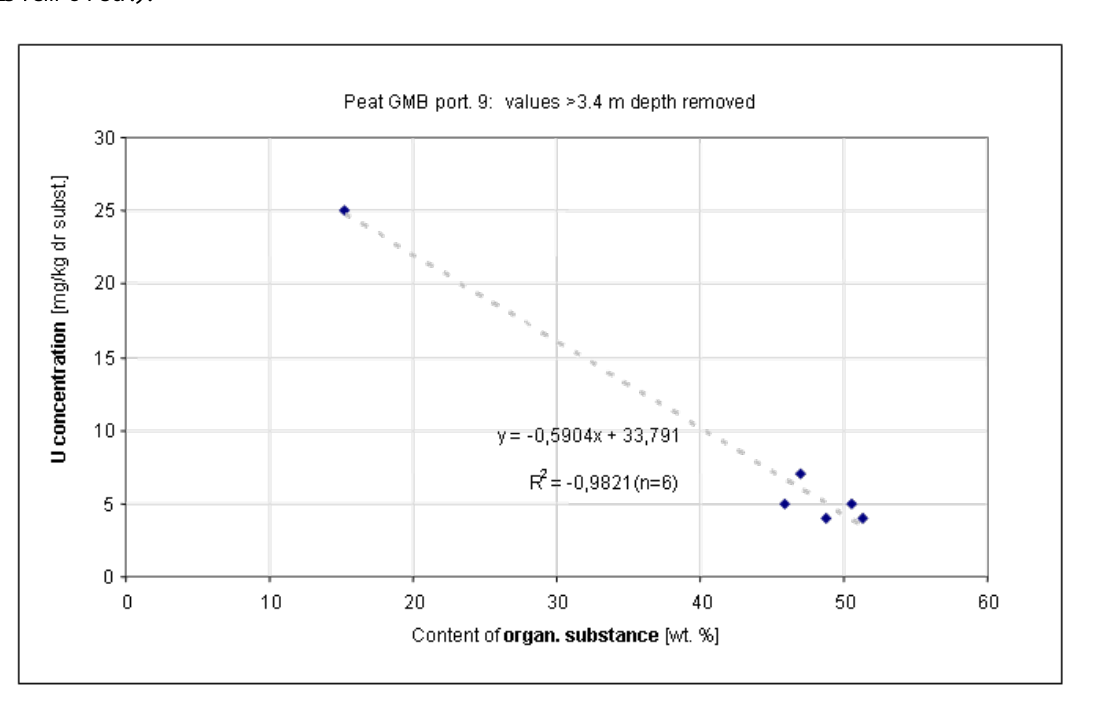
Figure 9. Relationship between U concentration and content of organic substance in peat samples taken at portion 9 above a depth of 3.4 m (Please note: the inclusion of the outlier value does not change the linear nature of the relationship which persists when it is